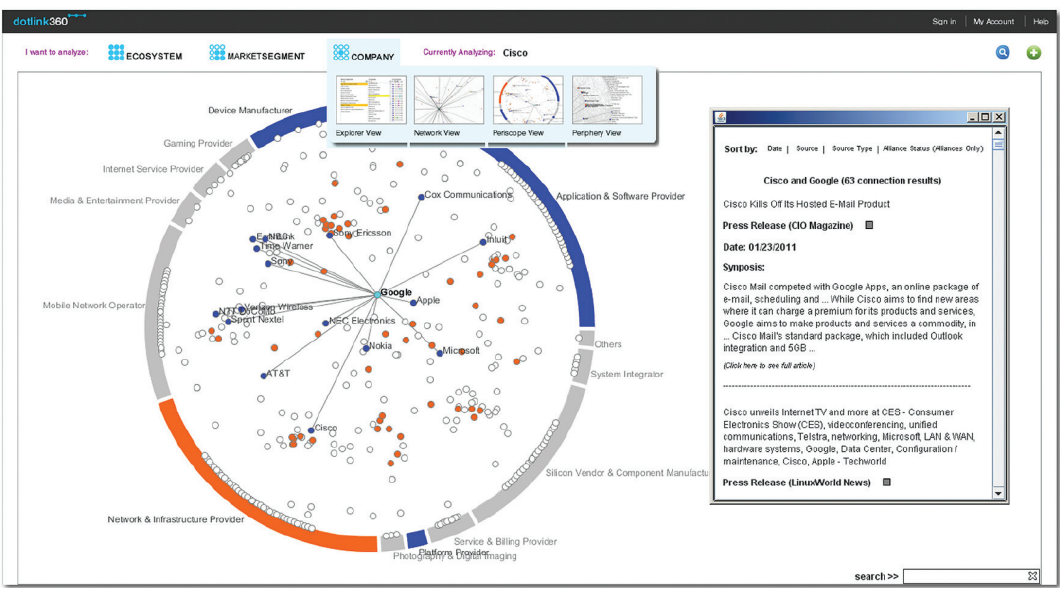
Figure 15. The dotlink360 application. This network clusters firms by industry. The position of the nodes is based on the weight of their involvement within each of the industries listed around the perimeter. The user can select a firm to see their involvement with other companies within their ecosystem. Image courtesy of Basole et al.